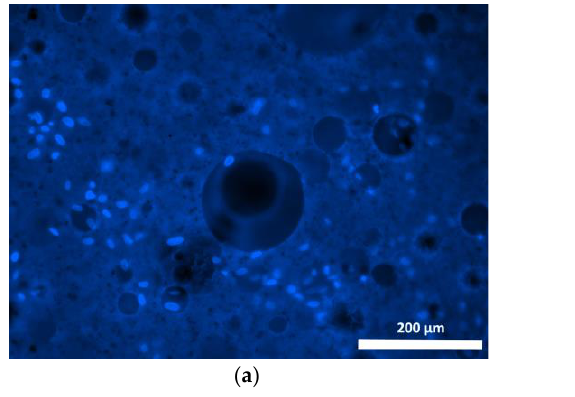
Figure 7. Fibroblast nuclei on the surface of Composition 2 specimen (staining fluorochrome — Hoechst 3334, BD Pharmingen ™ : ( a ) 24 h cultivation; ( b ) 72 h cultivation. Mag. 100×.